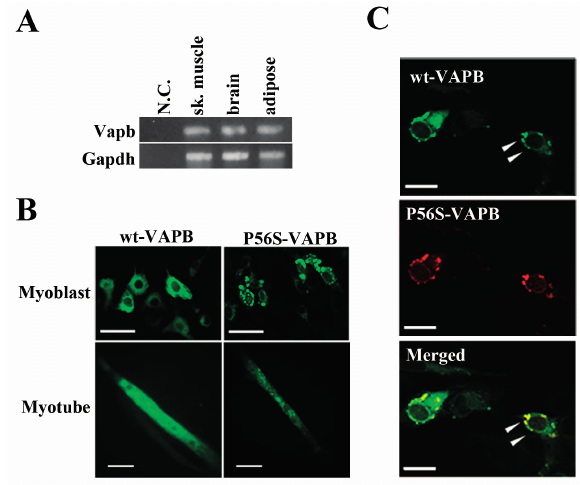
Figure 1. P56S mutation leads to aberrant aggregation of VAPB in C2C12 cells. ( A ) VAPB mRNA expression was analyzed by RT-PCR. Total RNA was collected from the indicated tissues of mice. N.C. indicates negative control (sample in which no reverse transcriptase was added); ( B ) C2C12 cells were transfected with the indicated plasmids and fixed either before inducing differentiation ( upper : Myoblast) or five days after differentiation ( lower : Myotube). The distribution of the VAPB protein is indicated by GFP expression; ( C ) C2C12 cells were co-transfected with vectors encoding C-terminally GFP-fused wt-VAPB and Ds-Red-fused P56S-VAPB, followed by fixation 24 h after transfection. Scale bar = 20 μ m. The merged image is shown on the bottom. Examples of co-localization are indicated with arrowheads. These images are representative of three similar